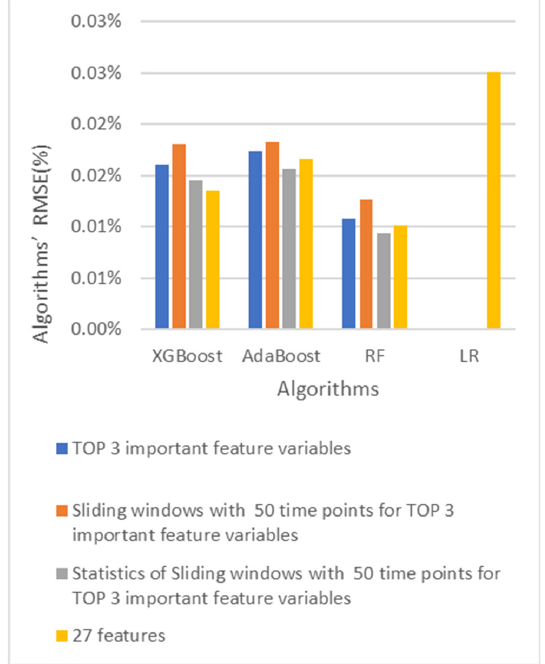
Figure 4. Comparison of the RMSE of algorithms when selecting different input variables (accuracy within 0.03%).